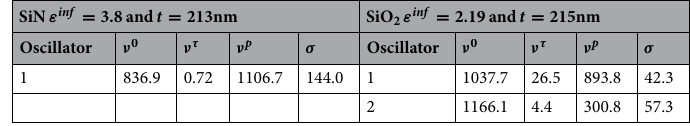
Table 1. Fitted Brendel oscillator parameters for SiN and SiO 2